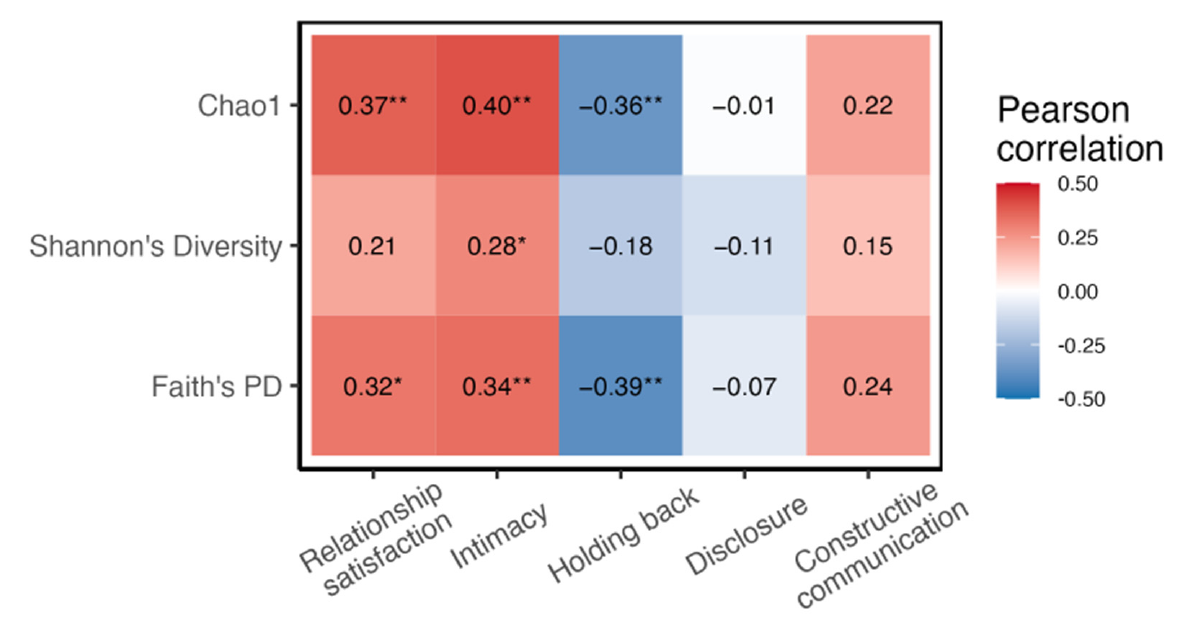
Figure 3. Pearson correlation between alpha diversity metrics and individual psychosocial measures. The value in each color block represents the Pearson correlation coefficient between one alpha diversity metric and one psychosocial measure. ** p < 0.01; * p < 0.05; Faith’s PD: Faith’s phylogenetic diversity. See Supplemental Table S3 for exact p -values.